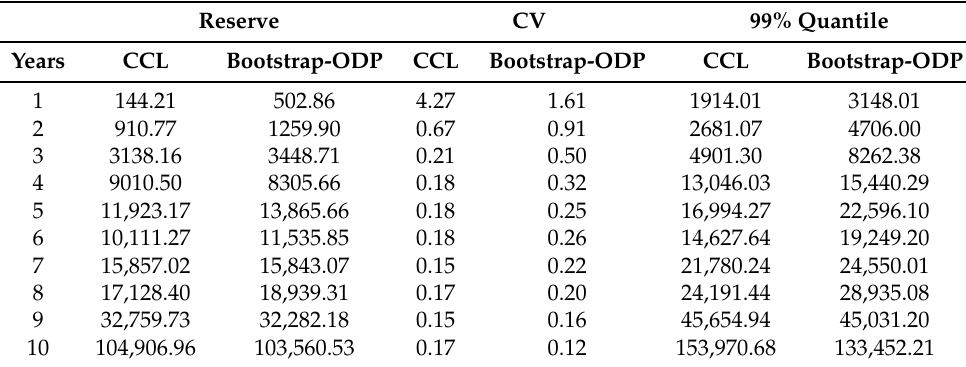
Table 4. We provide a comparison between CCL and Bootstrap-ODP method. For both methods, we report main characteristics (mean, coefficient of variation (CV), and 99% quantile). All the amounts are expressed in thousands of Euros and differentiated for accident years.